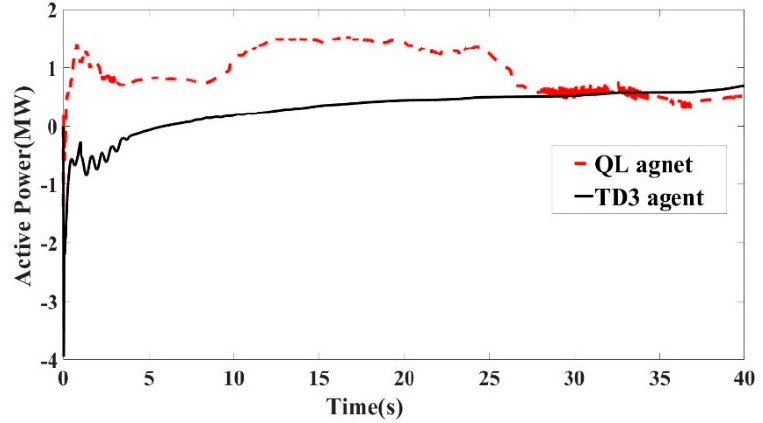
Figure 30. Active power with TD3 agent vs. Q ‐ learning.